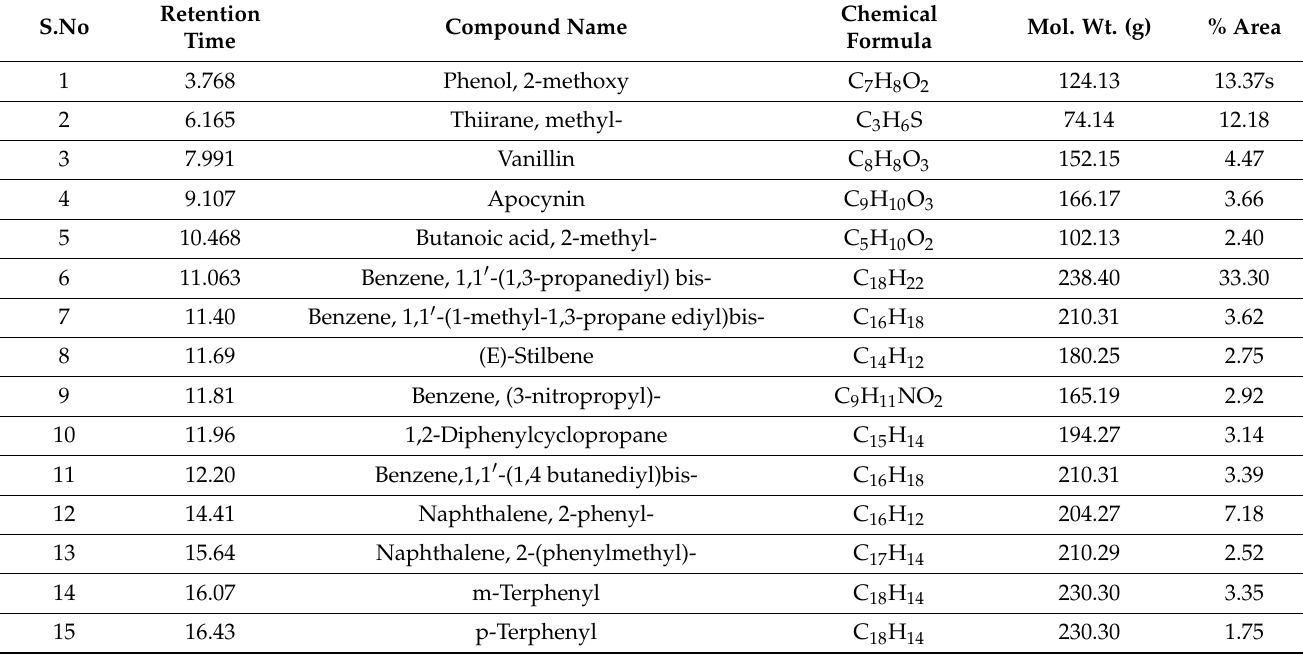
Table 3. Composition of bio-oil collected from lignin pyrolysis in the presence of